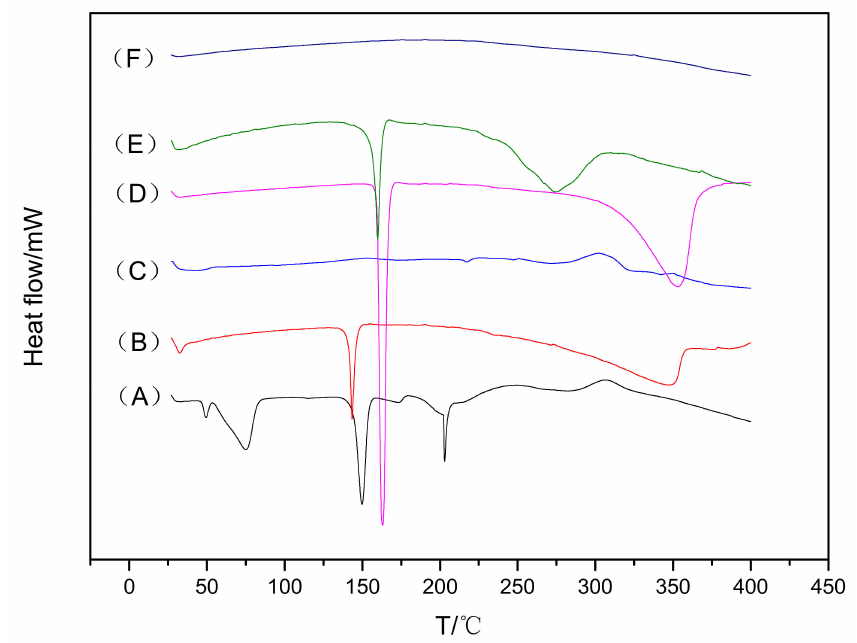
Figure 3. DSC analysis thermograms: (A) paeonol; (B) CHO; (C) SPC; (D) mannitol; (E) the physical mixture; (F) PAE ethosome freeze-dried